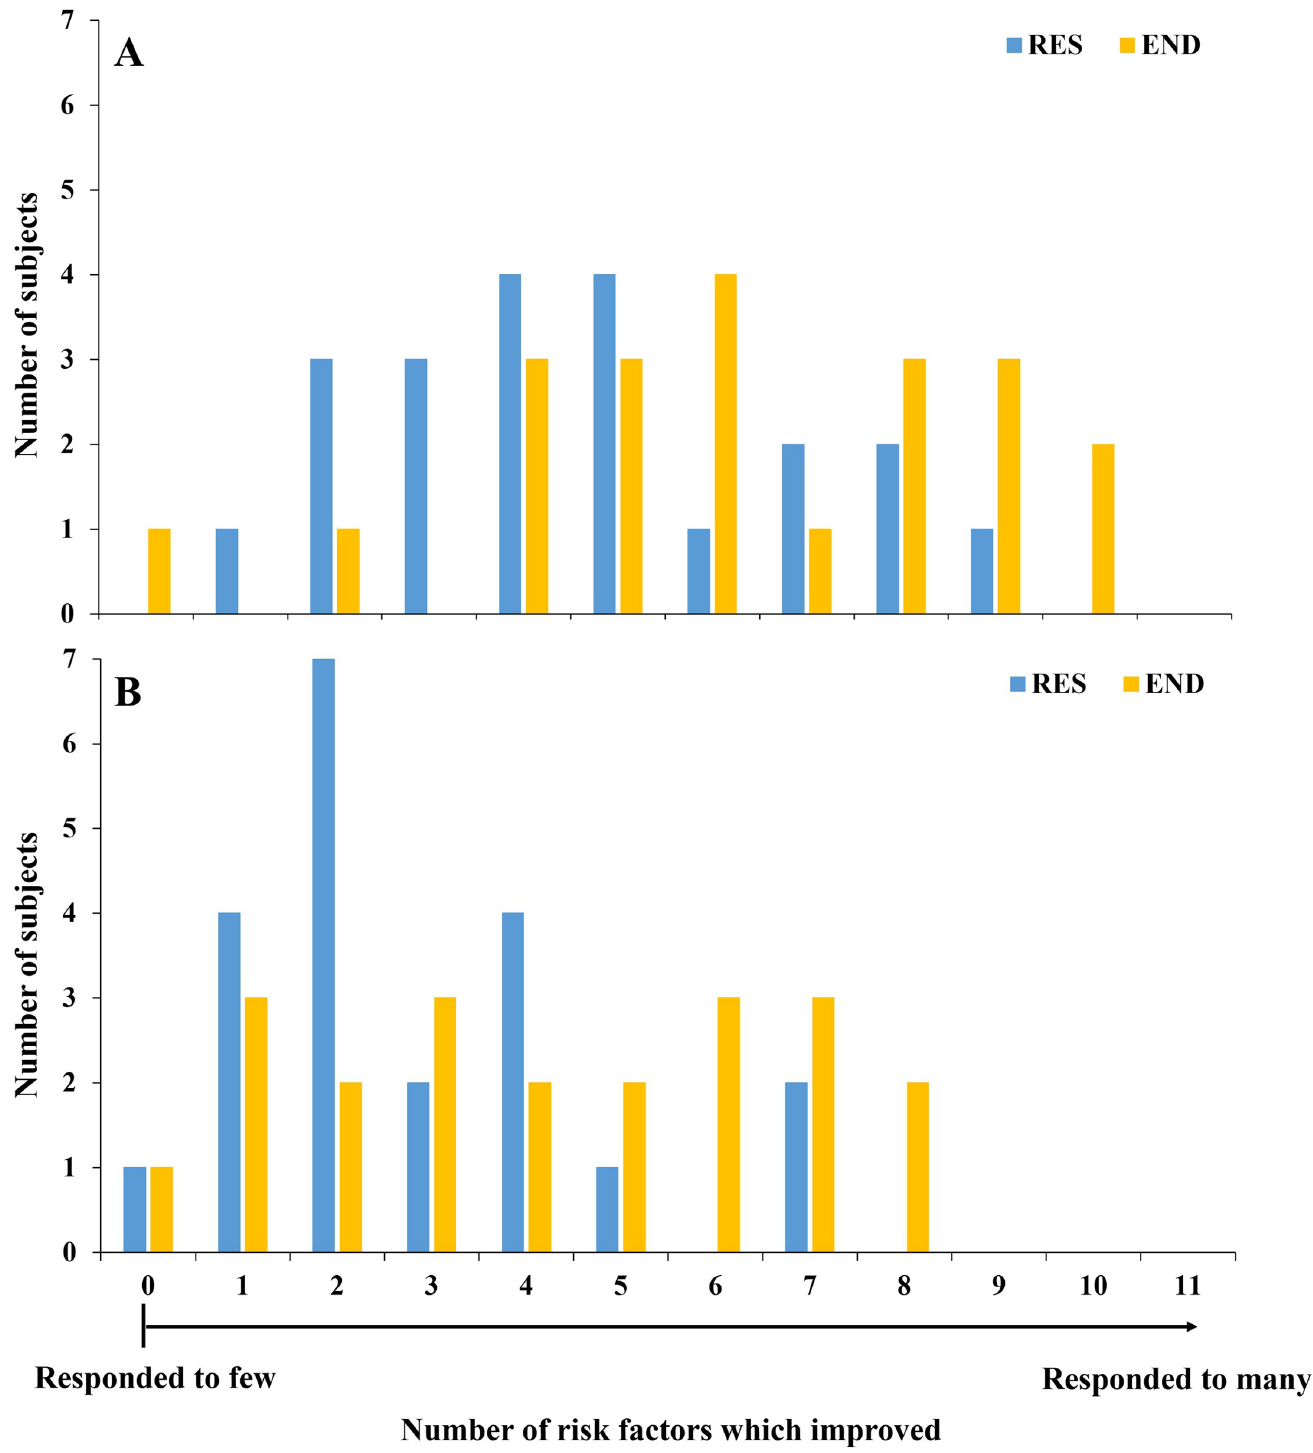
Fig 6. Displays the number of subjects who responded positively to outcome variables. The x axis reflects the number of variables to which individuals responded positively. Only subjects that had data available for every variable at all four time points were included (N = 21). Included variables are cholesterol, triglyceride, LDL, HDL, glucose, HOMA-IR, SBP, DBP, BMI, WHR, waist girth. Panel (A) reflects response defined as any beneficial response in an outcome variable, whereas (B) reflects the number of subjects who responded beneficially with a clinically meaningful change, as indicated by the dotted lines in Figs 2–4.